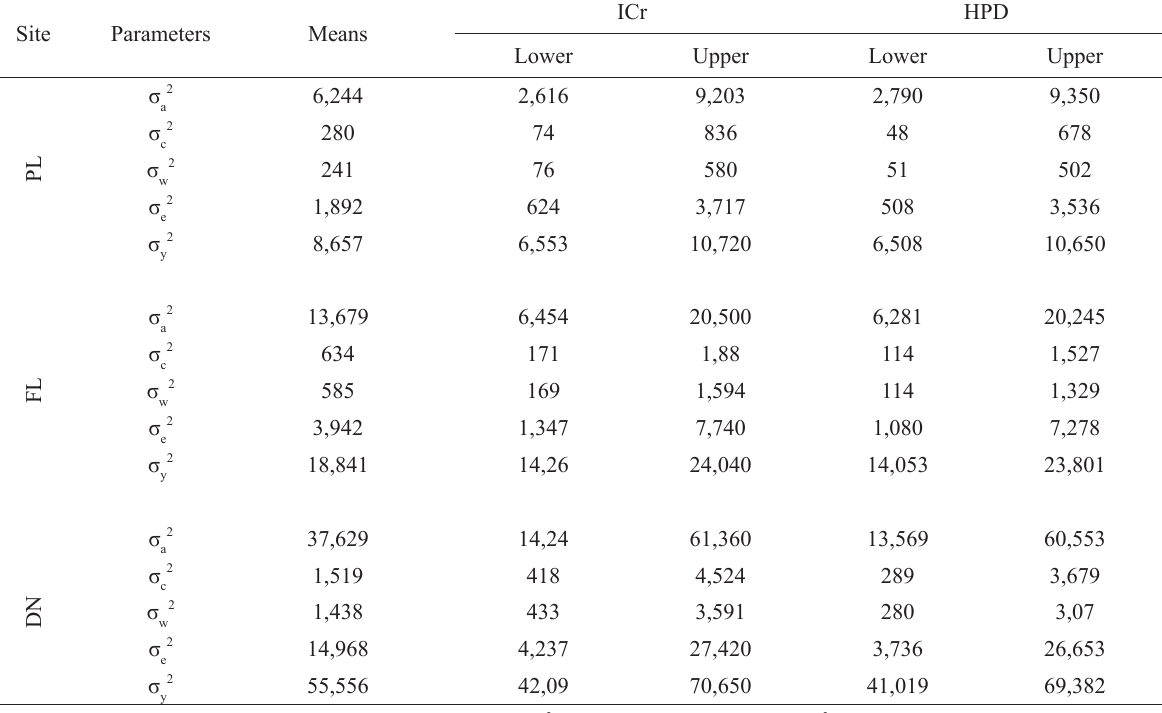
Credibility intervals (ICr) and high-density region (HPD), σ a2 : additive genetic variance; σ c2 : environmental variance common to larvae culture; σ w2 : environmental variance common to fingerlings; σ e2 : residual variance; σ y2 : phenotypic variance.